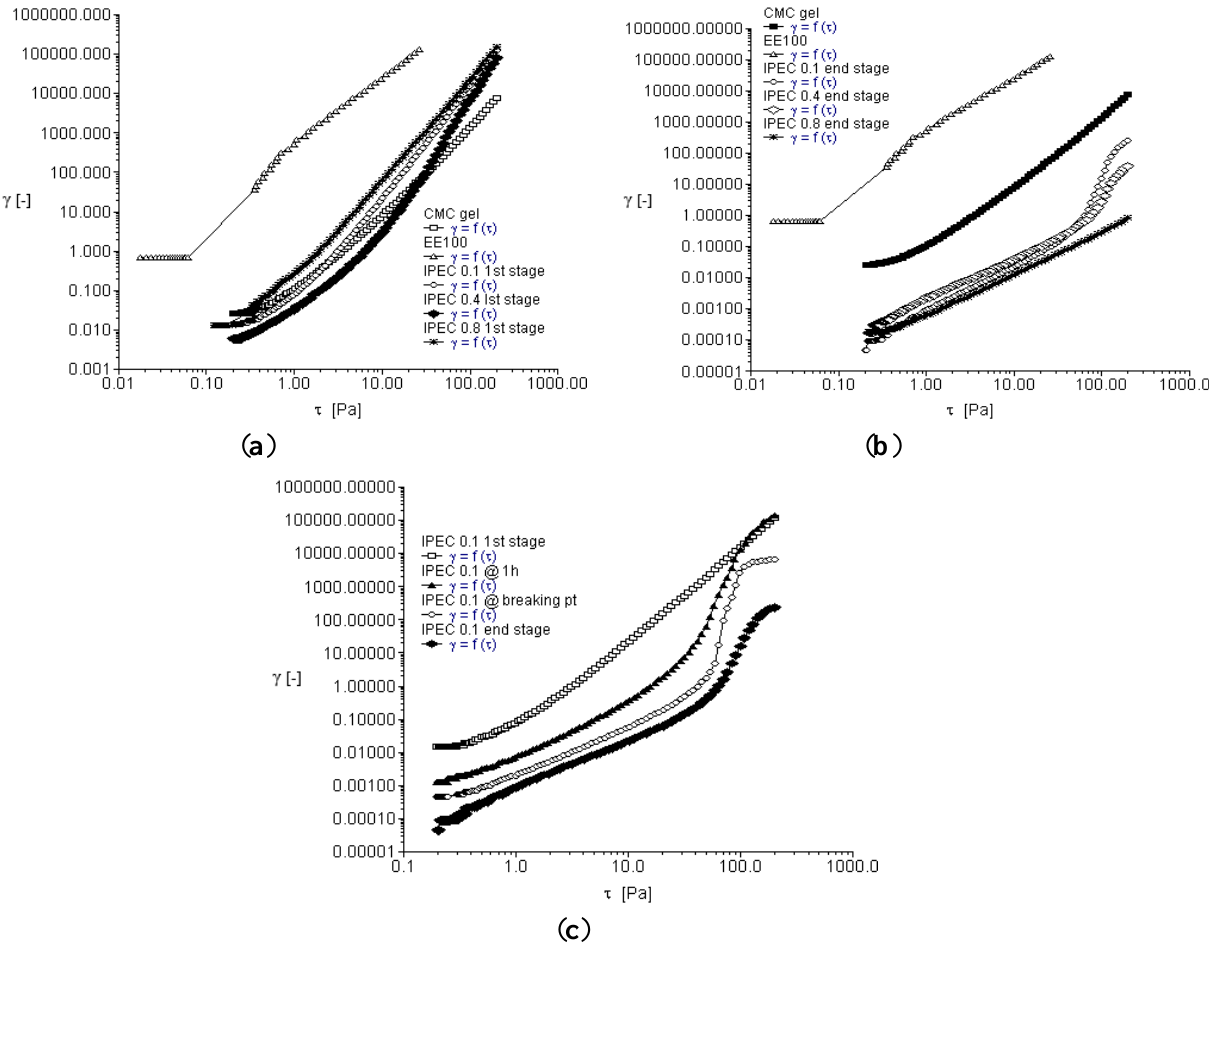
Figure 2. Yield stress rheogram for ( a ) the native polymers and IPEC at the first stage of synthesis; ( b ) the native polymers and IPEC at the end stage of synthesis; and ( c ) IPEC at the four sampling points of synthesis using 0.1 N acetic